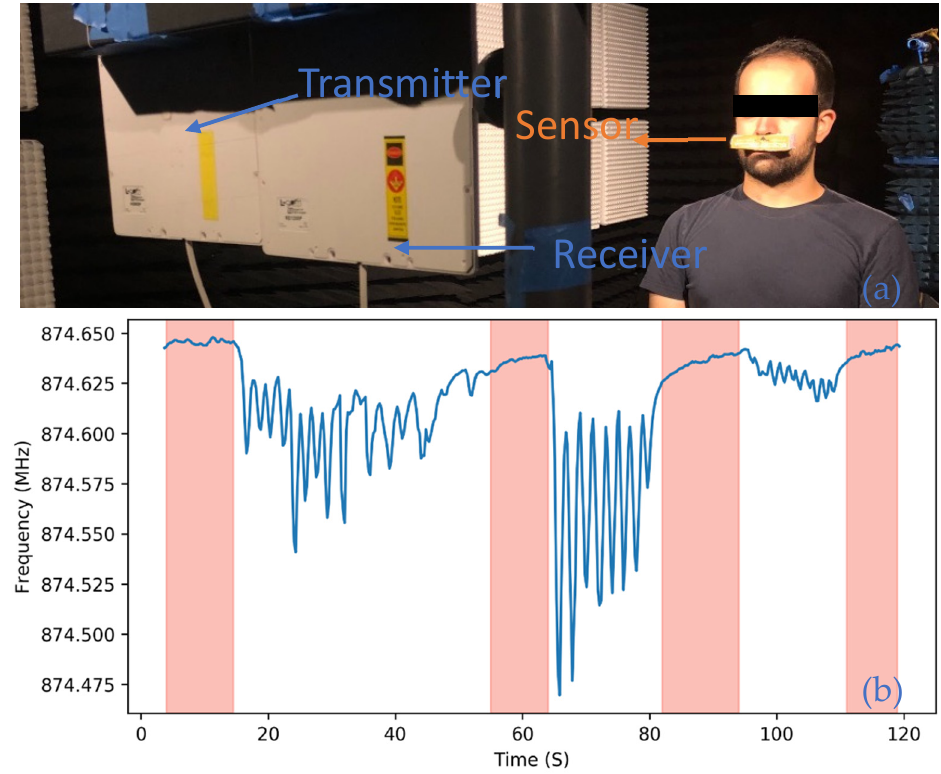
Figure 12. ( a ) Human respiratory measurement setup, illustrating the sensor placed on the patient’s upper lip region. ( b ) Respiratory profile of a human subject demonstrating non-uniform, uniform moderate, and shallow respiration in that order. Each drop in the frequency and subsequent recovery constitutes a single exhalation and inhalation cycle. Periods in which the patient ceased to breathe are highlighted in red.